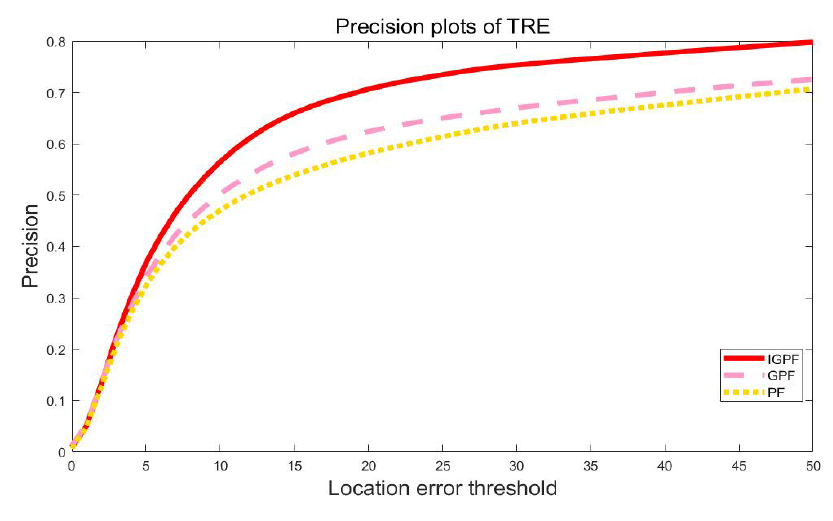
Figure 7. DP TRE curve.